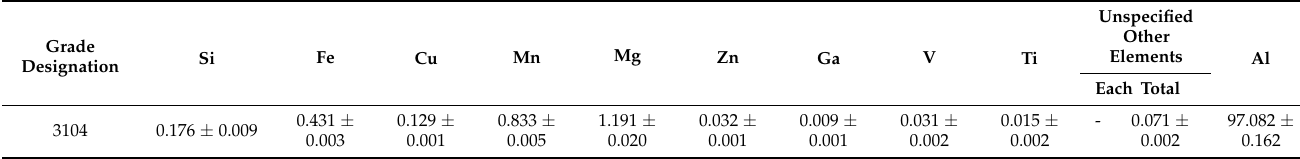
Table 1. Chemical composition (in wt%) of the AA3104 alloy [20].